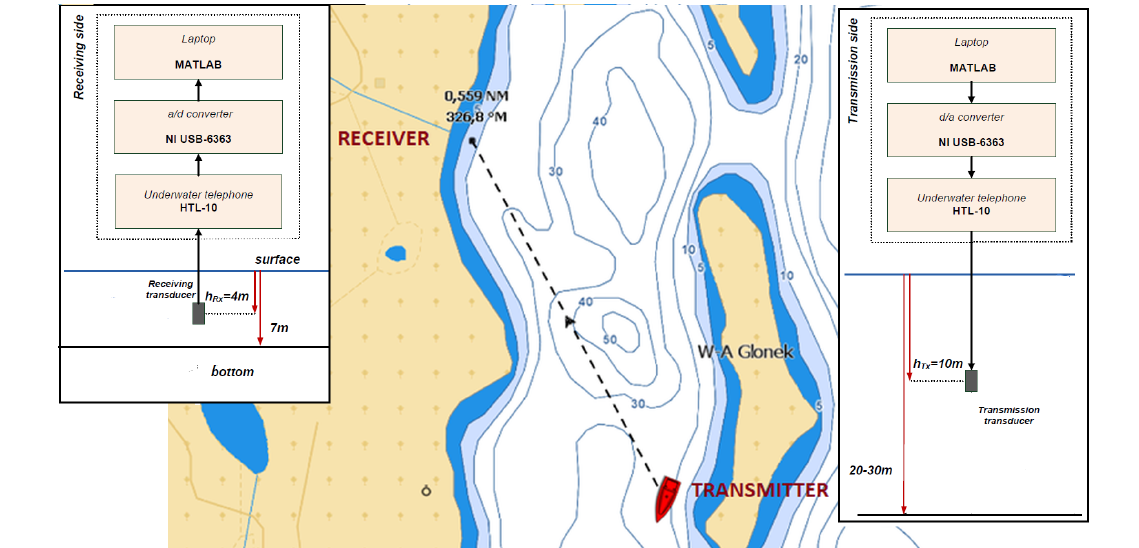
Figure 2. Localisation of inland water experiment and hardware setup.